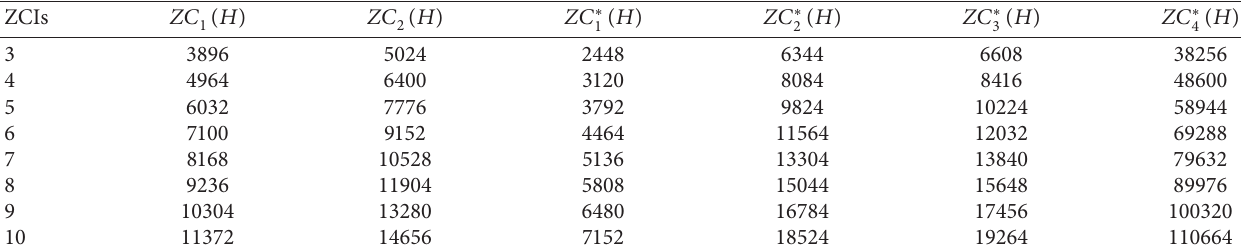
Table 15: Numerical table for indicated ZCIs of network H on dimensions 3 ≤ n ≤ 10.